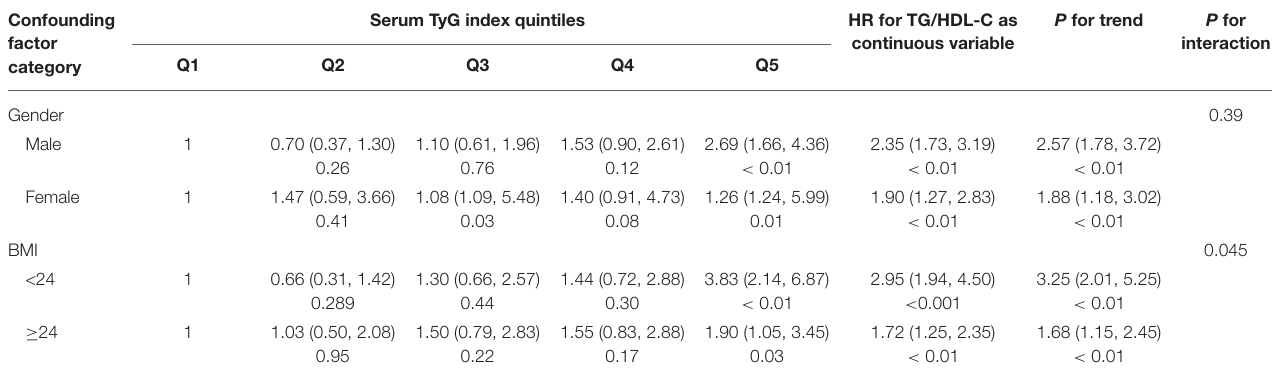
TABLE 3 | Subgroup